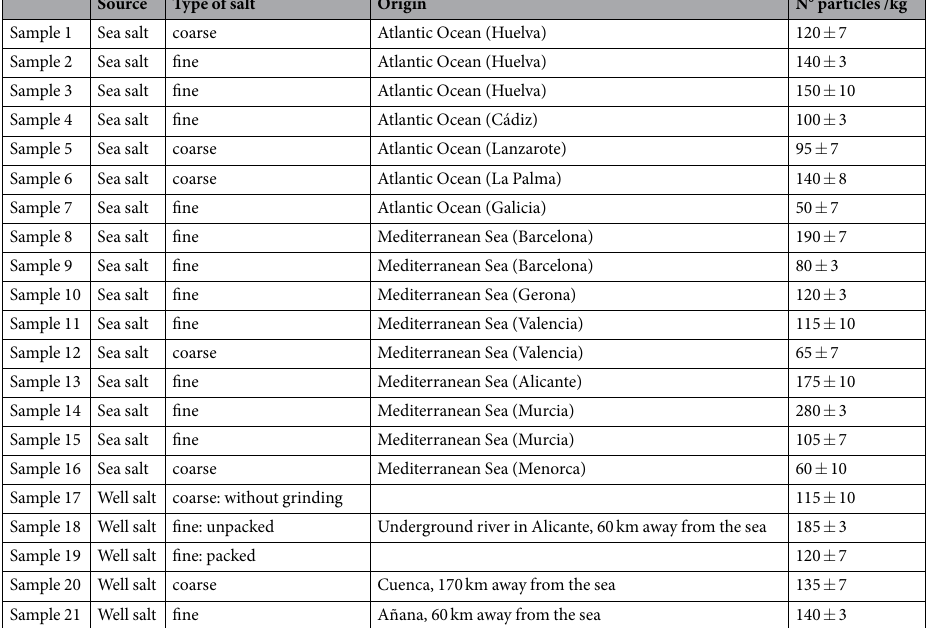
Table 1. Number of microplastics found in the different types of table salt analyzed.